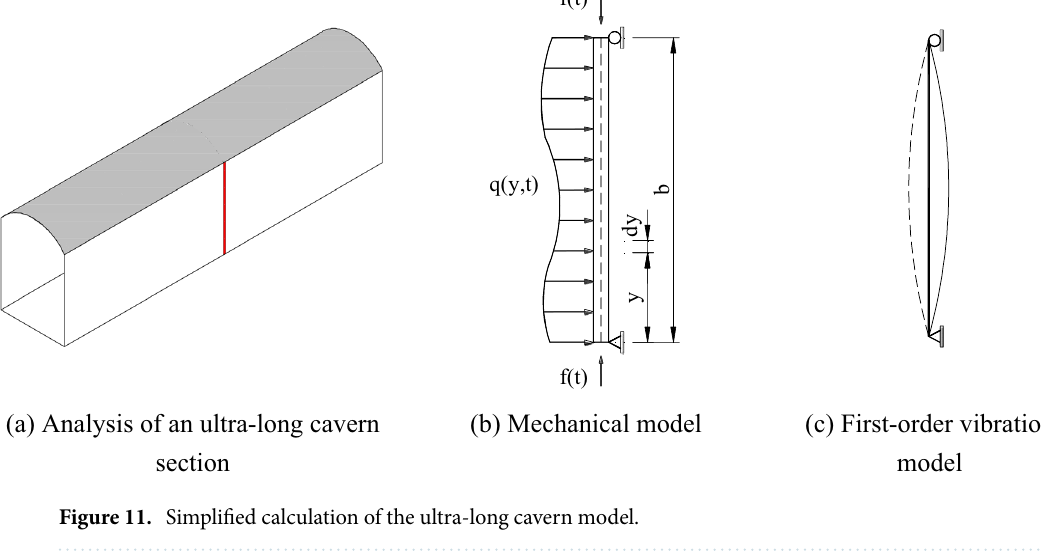
Figure 11. Simplified calculation of the ultra-long cavern